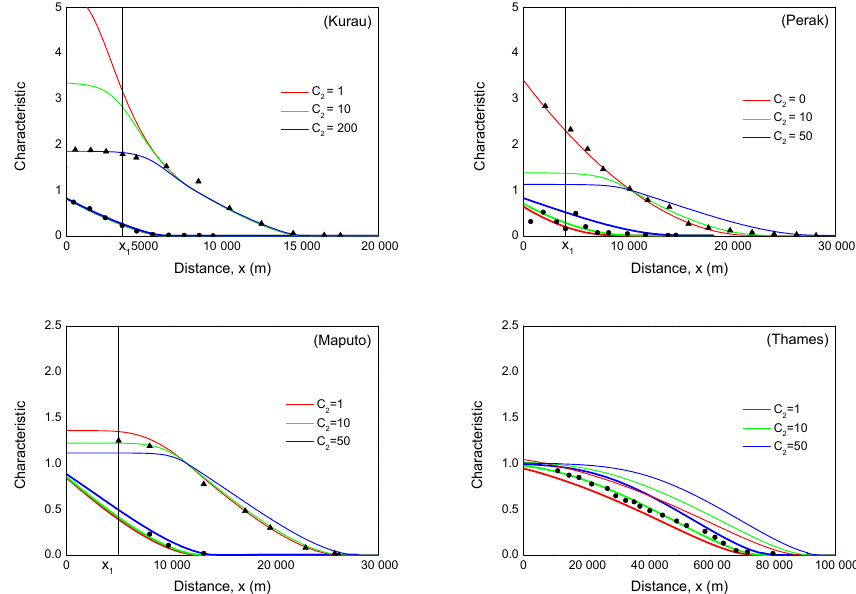
Figure 4. Comparison between simulated and observed salinity at high water slack (thin lines) and low water slack (thick lines), scaled by the salinity s 1 at the inflection point x 1 for different C 2 values. Observations at high water slack are represented by triangles and low water slack by circles. Observe that the Thames only has low water slack